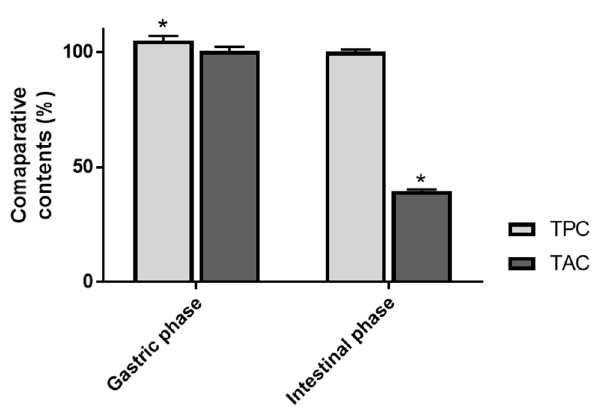
Figure 2. Impact of in vitro gastrointestinal digestion on Total Phenolic Content (TPC) and Total Anthocyanin Content (TAC) of bilberry extract. Data are presented as means ± SEM ( n = 3). All results are expressed as percentages, with control (i.e., undigested matrix) normalized as 100%. * p < 0.05 vs. control.